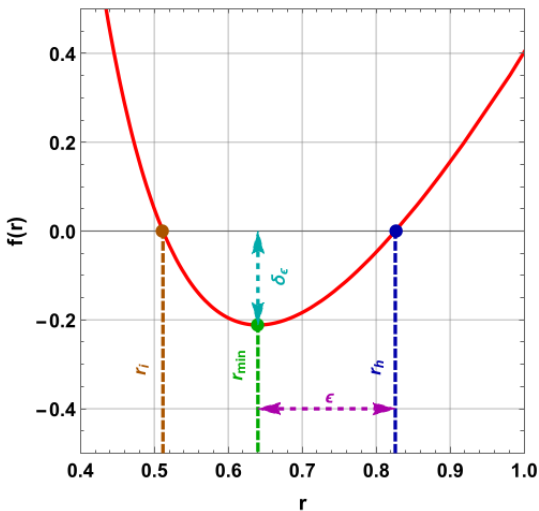
Figure 6. The variation of f ( r ) function in terms of r with D = 4 , Q = 1 , l = 1 and M = 1 . 3